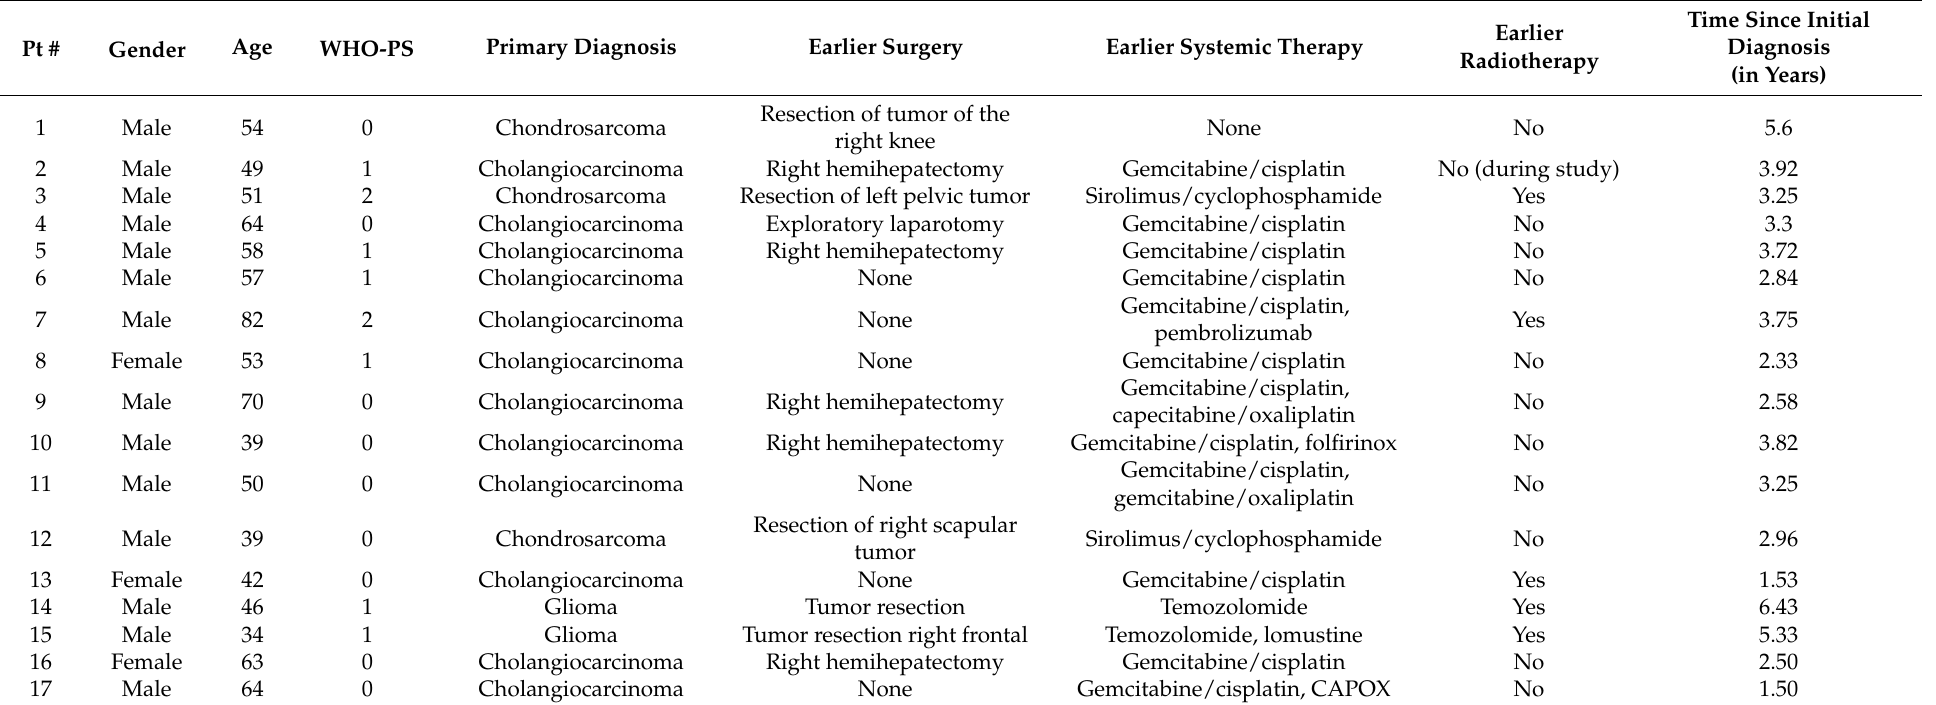
Table 2. Patient demographics and disease characteristics. Chemotherapy regimens were given in an advanced setting, unless stated